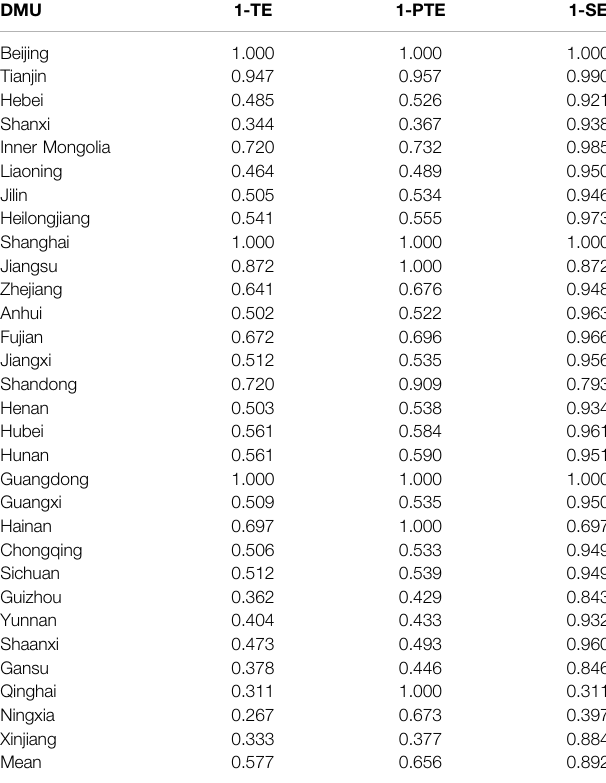
TABLE 1 | Regression results of the fi rst